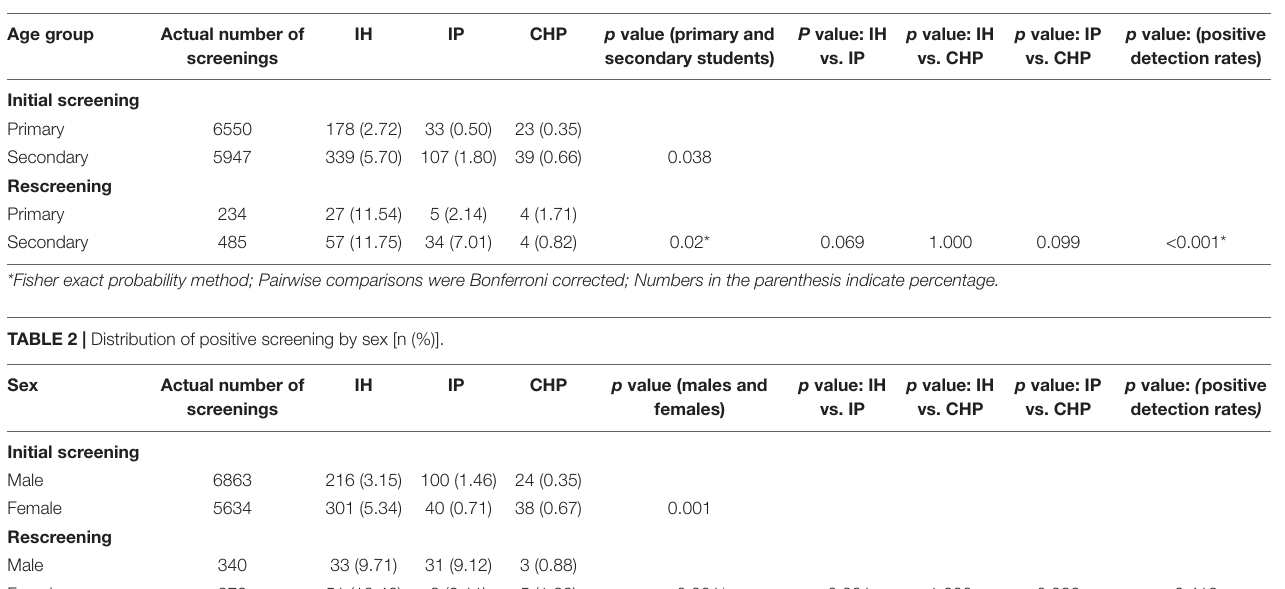
TABLE 1 | Distribution of positive screening by grade [n (%)].